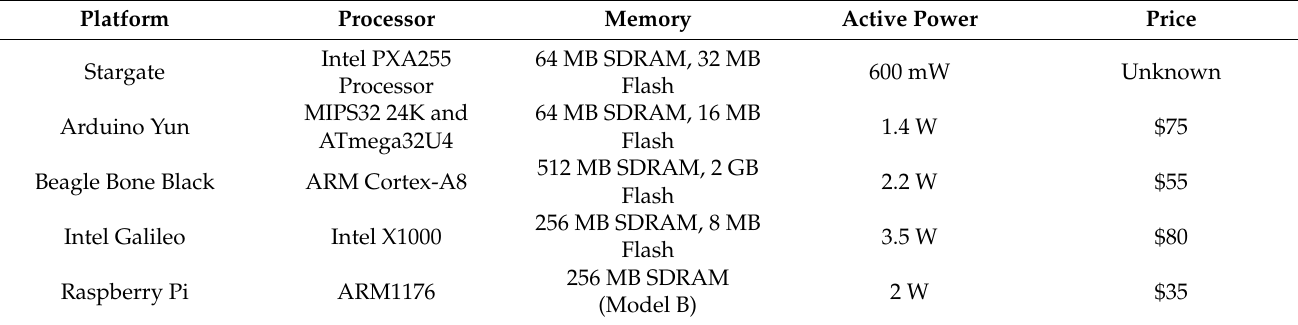
Table 2. Complex microcontroller-based